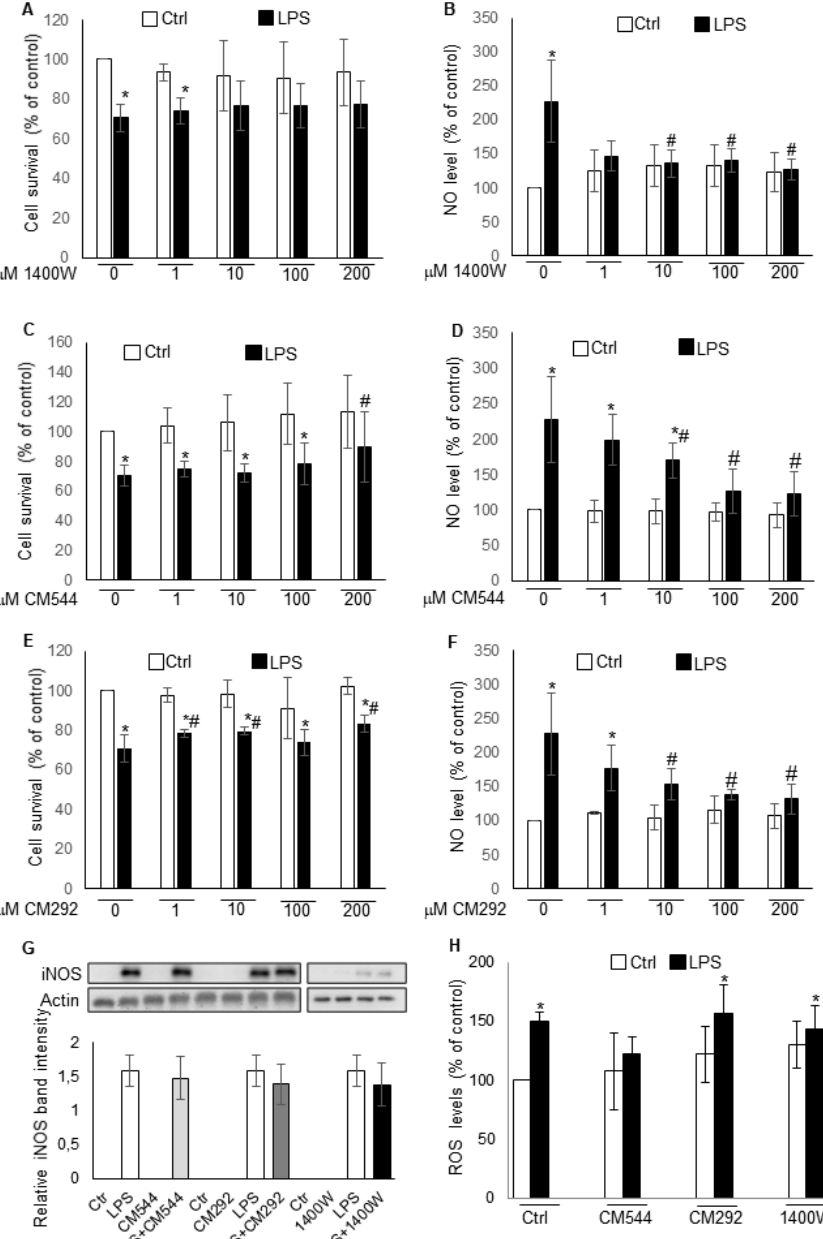
Figure 2. iNOS inhibitors reduce nitric oxide (NO) production without affecting iNOS protein expression. BV2 microglial cells, pre-treated for 3h with 10 μ g/mL LPS, were then exposed for further 24h to different concentration of iNOS inhibitors and used to determine ( A ), ( C ), and ( E ) cell viability, detected by MTT assay (absorbance of control cells 0.63 ± 0.05 was assumed as 100%). Data represent mean ± SD of n = 6 independent experiments performed in quadruplicate. * p < 0.05 vs. control cells. # p < 0.05 vs. LPS treated cells; ( B ), ( D ), and ( F ) NO production, detected by Griess reagent (absorbance of control cells 1.12 ± 0.25 was assumed as 100%). Data represent mean ± SD of n = 6 independent experiments performed in quadruplicate. * p < 0.05 vs. control cells. # p < 0.05 vs. LPS treated cells; ( G ) Western blotting analysis of iNOS. β -actin was used as loading control. Bars represent the ratio between respective protein and β -actin band intensity. The images are representative of one out of three separate experiments; ( H ) detection of ROS generation by DCF fluorescence (fluorescence of control cells 3.34 ± 0.83 was assumed as 100%). Data represent mean ± SD of n = 3 independent experiments performed in quadruplicate. * p < 0.05 vs. control cells.